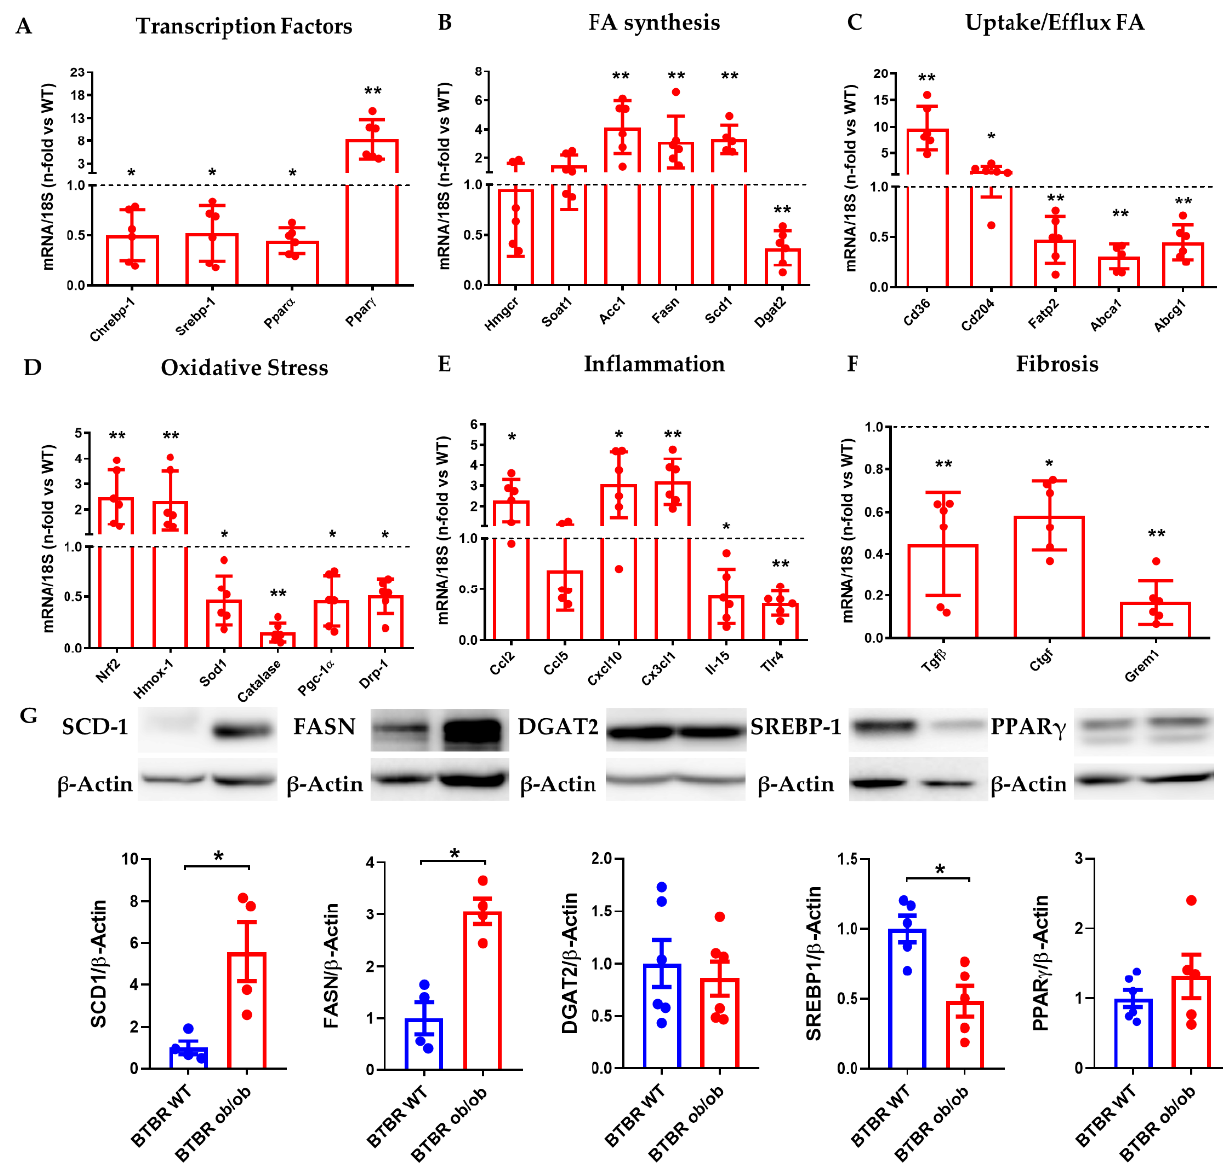
Figure 6. Liver gene and protein expression at 22 weeks. ( A ) mRNA expression by RT-qPCR of main transcription factors (Chrebp-1, Srebp-1, Ppar α , Ppar γ ), ( B ) fatty acids synthesis (Hmgcr, Soat1, Acc1, Fasn, Scd1, Dgat2), ( C ) uptake/efflux fatty acids (Cd36, Cd204, Fatp2, Abca1, Abcg1), ( D ) oxidative stress (Nrf2, Hmox-1, Sod1, Catalase, Pgc-1 α , Drp-1), ( E ) Inflammation (Ccl2, Ccl5, Cxcl10, Cx3cl1, Il-15, Tlr4), and ( F ) fibrosis (Tgf β , Ctgf, Grem1) was evaluated. Fold changes of the target gene was normalized by of their respective housekeeping gene 18s ribosomal subunit, ( G ) Protein expression of lipogenic enzymes by western blot was evaluated. Fold changes of proteins levels in BTBR ob/ob vs. BTBR WT (n-fold = 1) normalized by β -Actin and images of their respective Western Blot. Data are shown as scatter dot plots and mean ± SEM of each group ( n = 6 mice/group); * p < 0.05, ** p < 0.01 vs. BTBR WT.